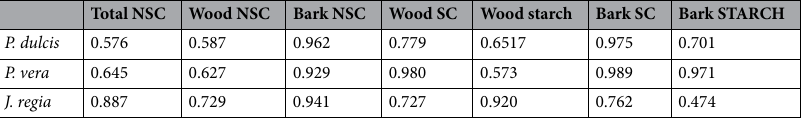
Table 4. Augmented Dickey Fuller (ADF) test for unit root in time series with lag time of 12 months.